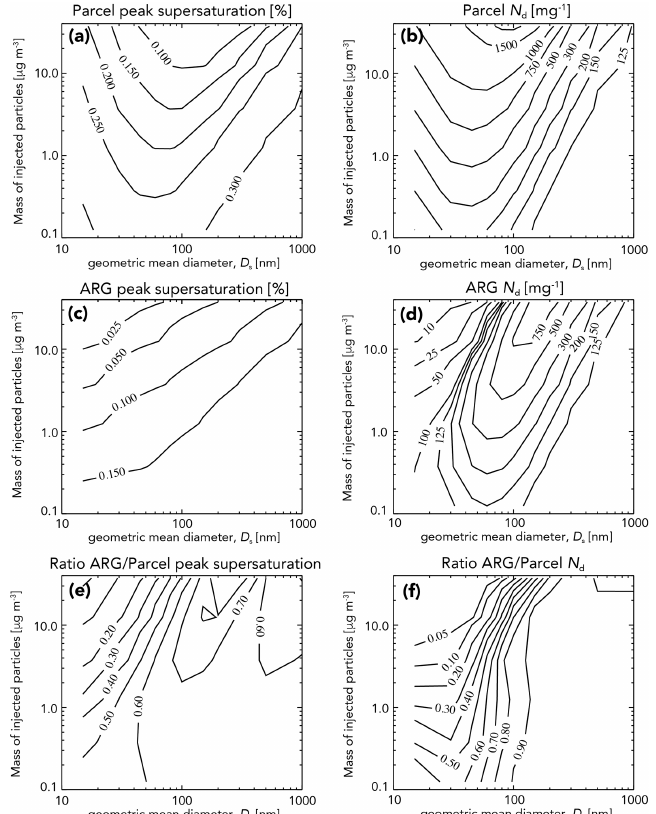
Figure A1. Comparison of the parcel model and ARG peak supersaturations (a, c, e) and activated cloud droplet concentrations N d (b, d, f) as a function of the injected particle geometric mean diameter D s and the mass loading of injected particles. The other parameters are set as w = 0 . 4ms − 1 , N 0 , acc = 100mg − 1 , and N 0 , coarse = 10mg − 1 (base values used throughout the paper). Panels (a) – (b) show results from the parcel model, panels (c) – (d) from ARG, and panels (e) – (f) are the ratio of ARG to the parcel